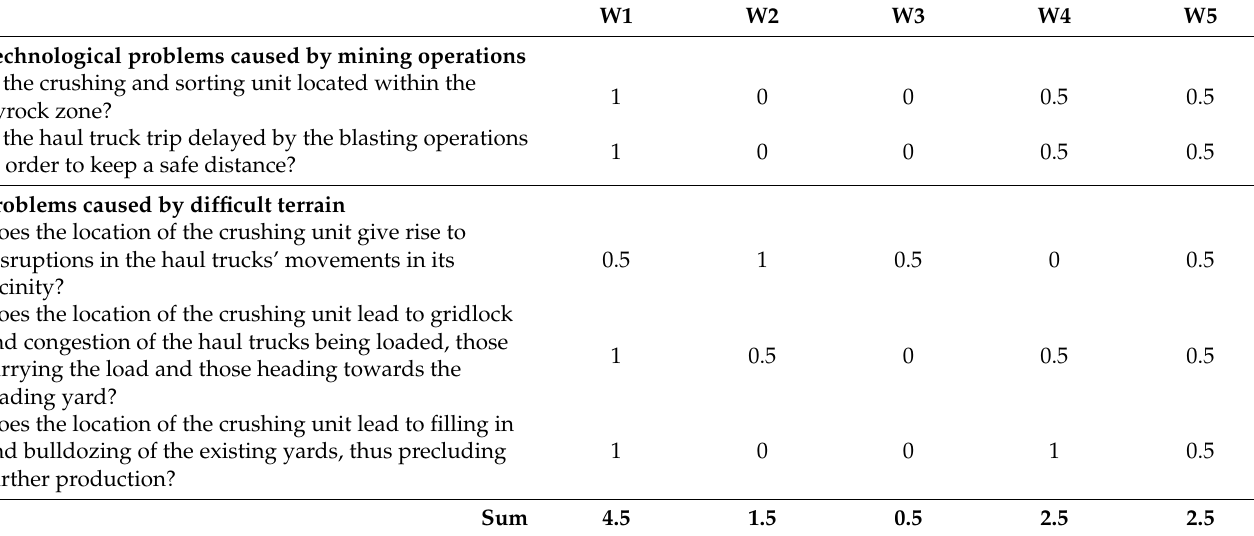
Table 1. Possibility of unplanned downtime due to the location of the crushing